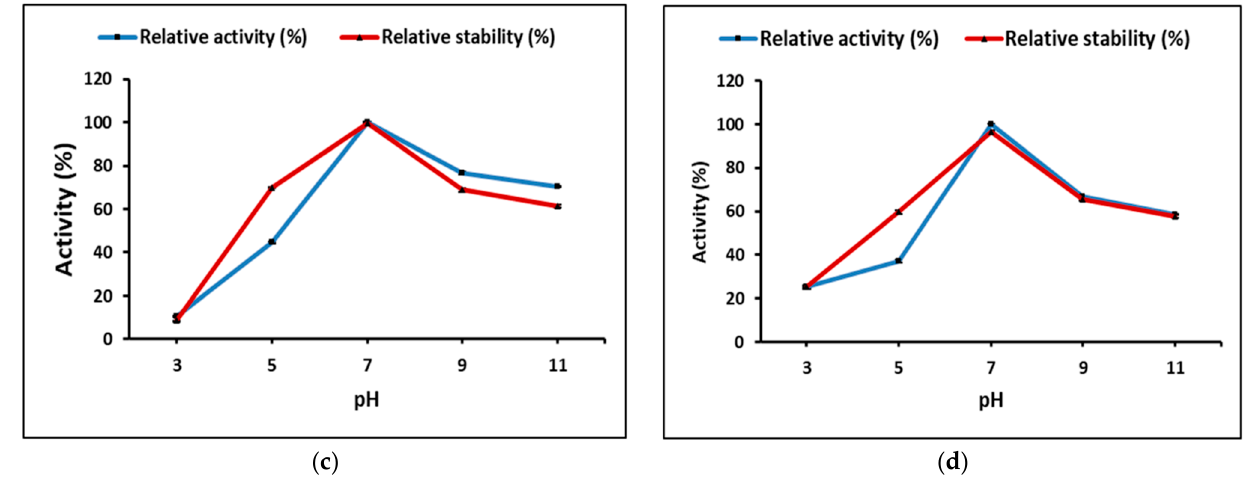
Figure 8. Effects of pH on activity and stability of partially purified cellulase: ( a ) M. circinelloides ; ( b ) M. hiemalis ; and pectinase: ( c ) M. circinelloides ; and ( d ) M. hiemalis . Table 10. Effects of metal ions and detergents on activity and stability of partially purified cellulase from M. circinelloides and M. hiemalis .